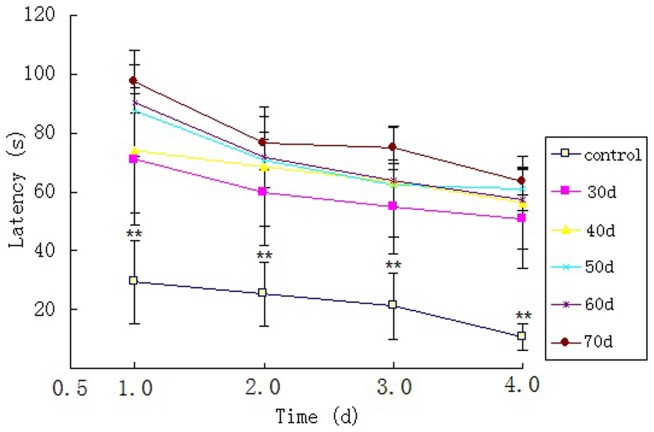
A tendency toward a decreased latency in MWM during place-training trials, while the number of training was increased along the sessions in any group.Data is presented as ±s (** p<0.01: D-galactose and NaNO2 treated group vs. control group, at the same time point, n = 6).